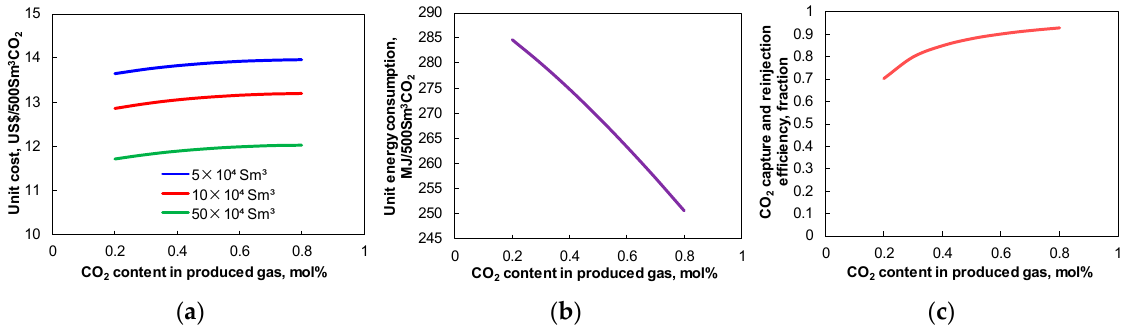
Figure 7. Calculation results of the evaluation indicators of the DRM process. ( a ) Unit cost; ( b ) Unit energy consumption; ( c ) CO 2 capture and reinjection efficiency